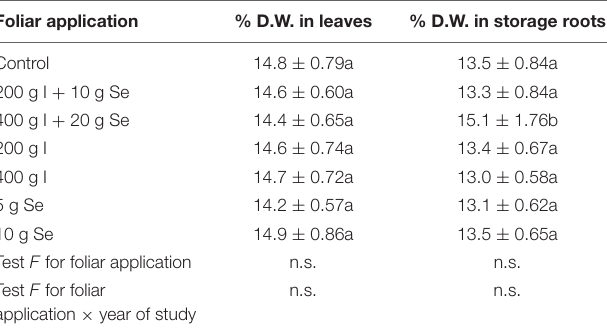
TABLE 7 | Content of dry weight in leaves and storage roots of carrot, depending on the foliar application of iodine and selenium. Foliar